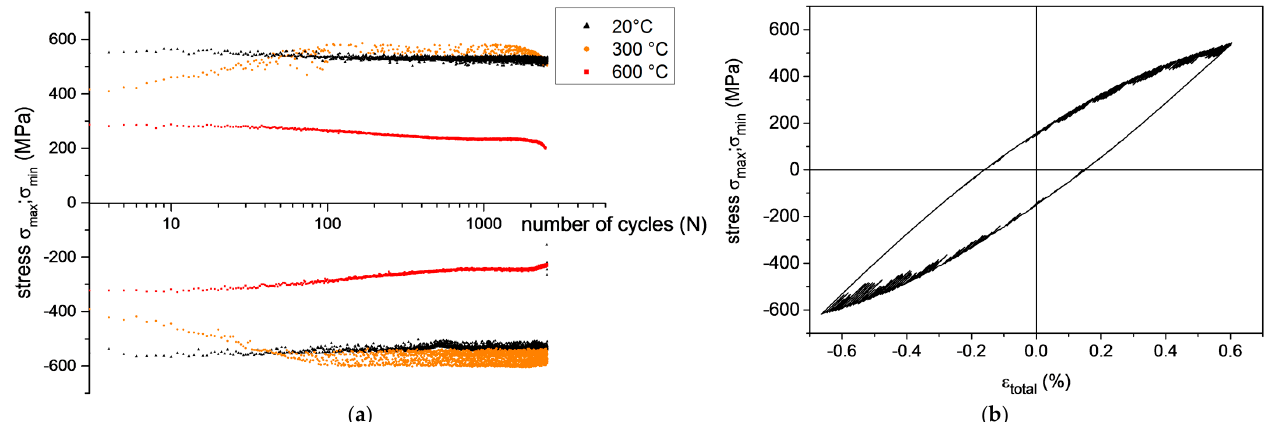
Figure 3. ( a ) Cyclic stress response curves of isothermal fatigue tests (20, 300 and 600 °C) carried out under plastic-strain control at a plastic-strain amplitude of 0.2% (f = 0.0059 Hz); ( b ) exemplary single stress–total strain hysteresis loop of the 800th cycle of the isothermal test at 300 °C.